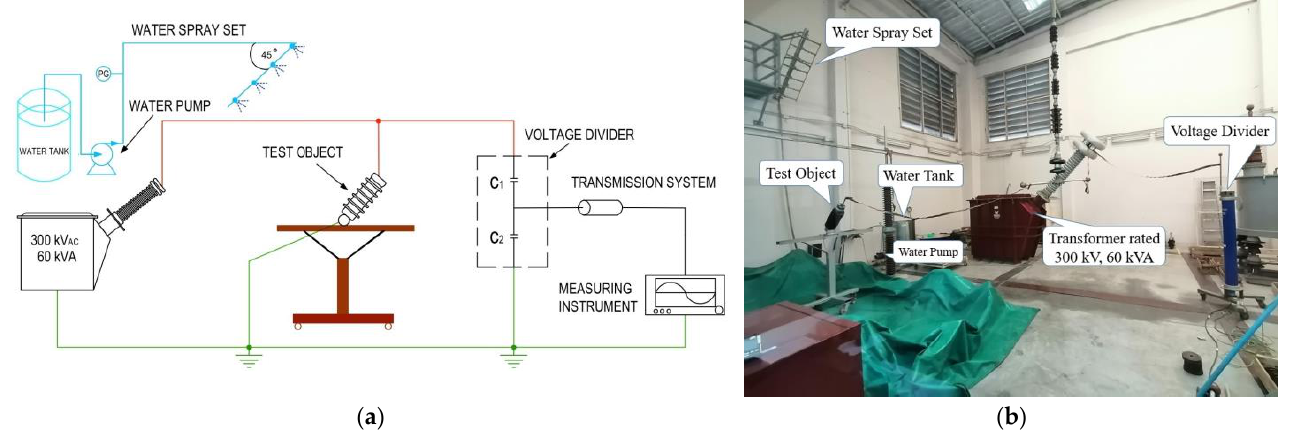
Figure 7. The experimental circuit of low-frequency flashover AC voltage under wet test. ( a ) The circuit diagram on low-frequency wet-flashover test; ( b ) The test circuit set-up on low-frequency wet-flashover test.